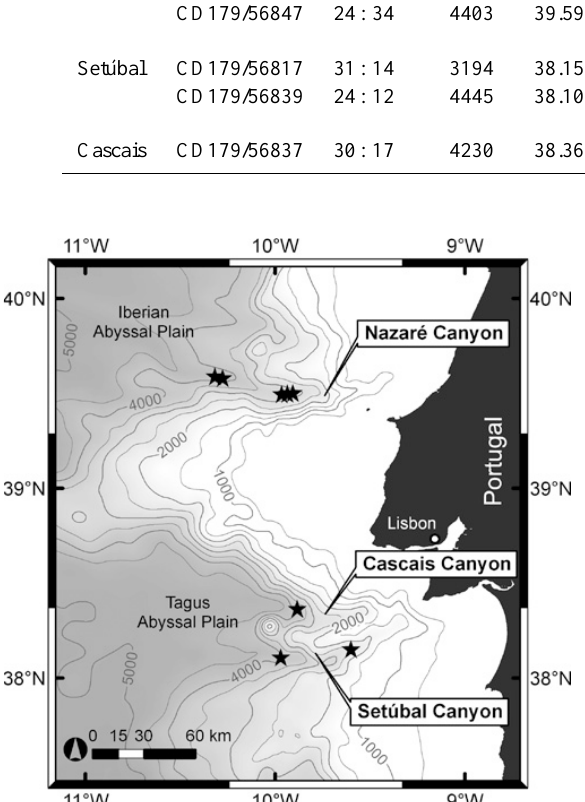
Fig. 1. Map of Iberian Peninsula submarine canyon trap deploy- ments as part of research expeditions RRS Discovery 297, RRS Charles Darwin 179, and RRS James Cook